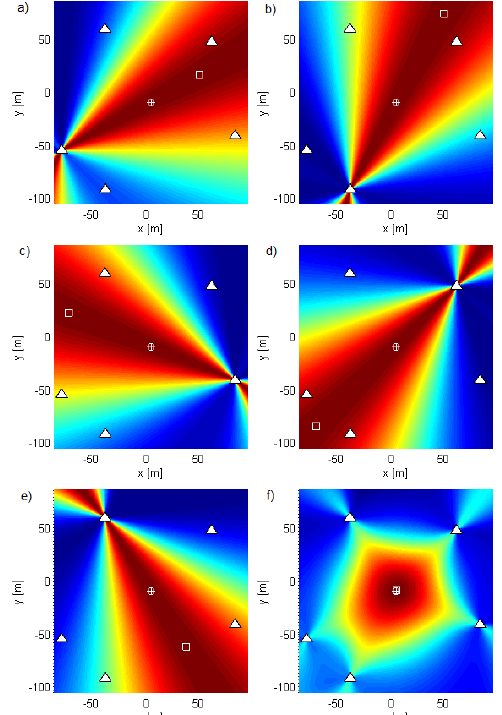
Figure 5. ML-US criterion functions for f c = 4500 ( ν c = 900 MHz) and ν s = 200 kHz applied to ( a – e ) individual two-element subarrays in G 10 and ( f ) the sum of these functions.